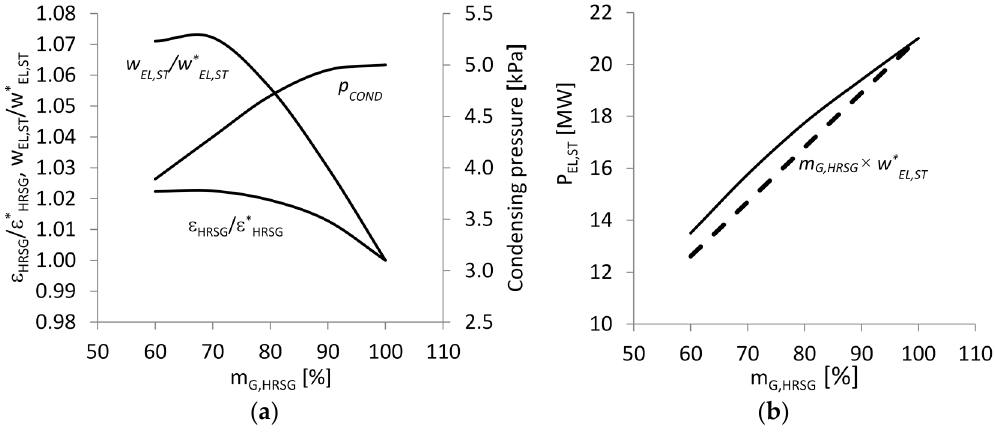
Figure 2. ( a ) HRSG effectiveness, electricity production per kilogram of gas and condensing pressure by varying the mass of gas entering the HRSG; ( b ) GSCC steam section power output.